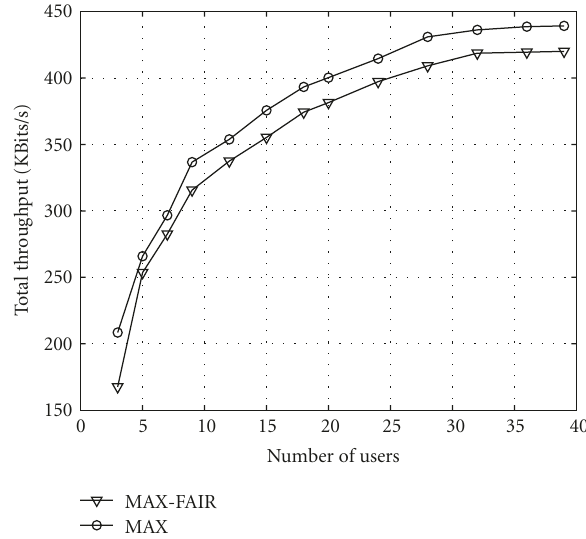
Figure 8: System throughput as a function of the number of backlogged